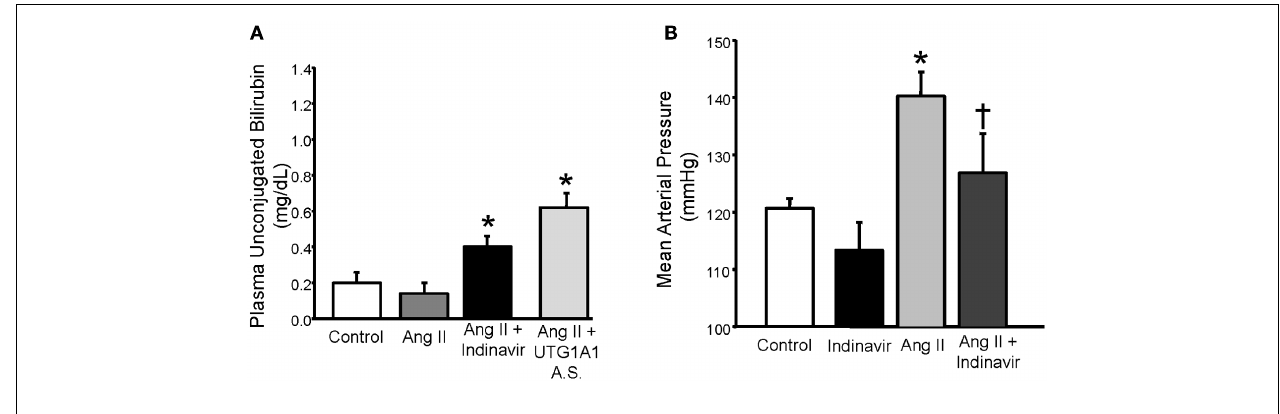
at 1 μ g/kg/min and continuing throughout the 12day infusion. Blood pressure was measured in conscious freely moving mice by fluid filled catheters. Ang II infusion increased blood pressure and this increase was significantly attenuated by moderate hyperbilirubinemia. * P < 0.05 as compared control. † P < 0.05 vs. Ang II. Figure modified fromVera et al.